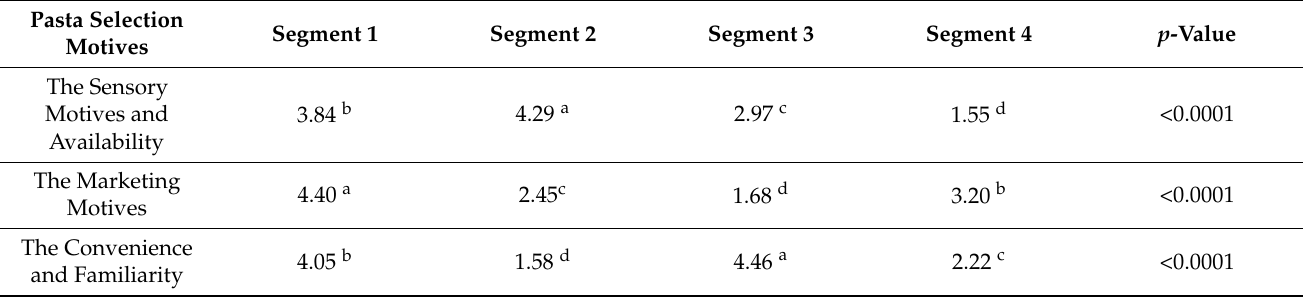
Table 2. Characteristics of the identified segments according to the motives of pasta selection; the mean ratings of the segments on the classification